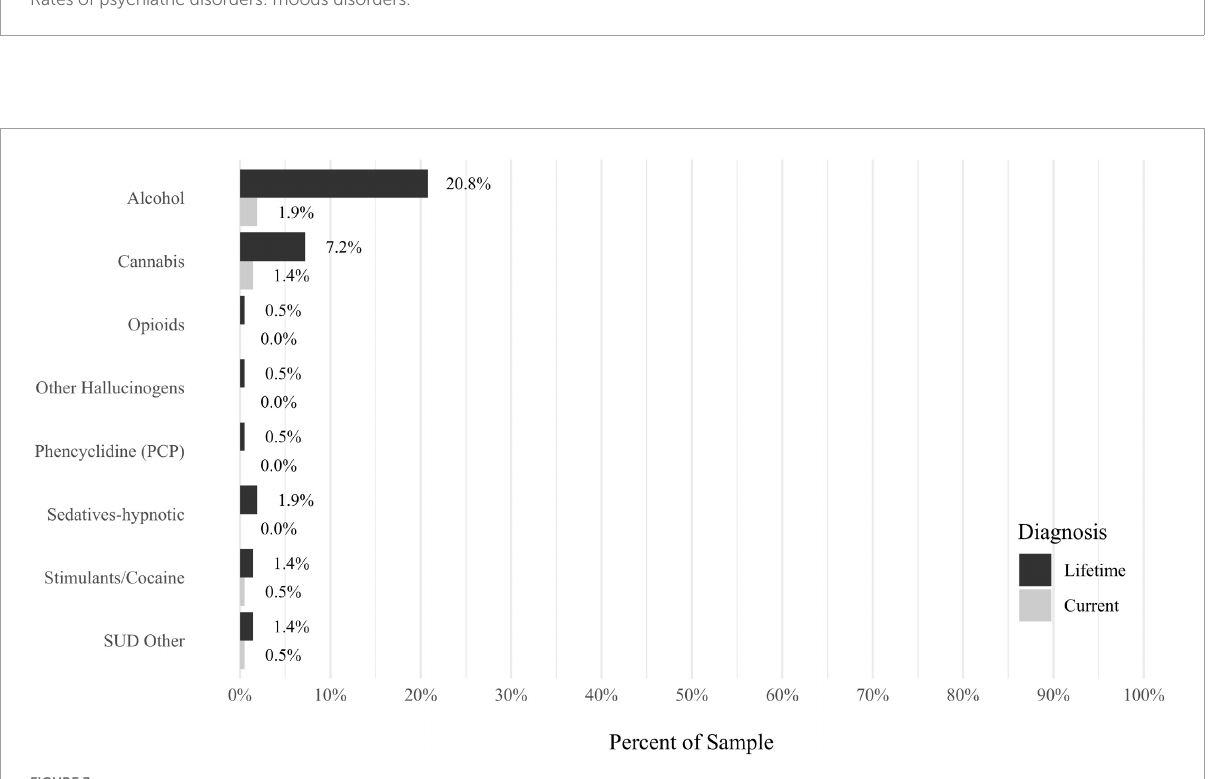
FIGURE2 Rates of psychiatric disorders: moods disorders.